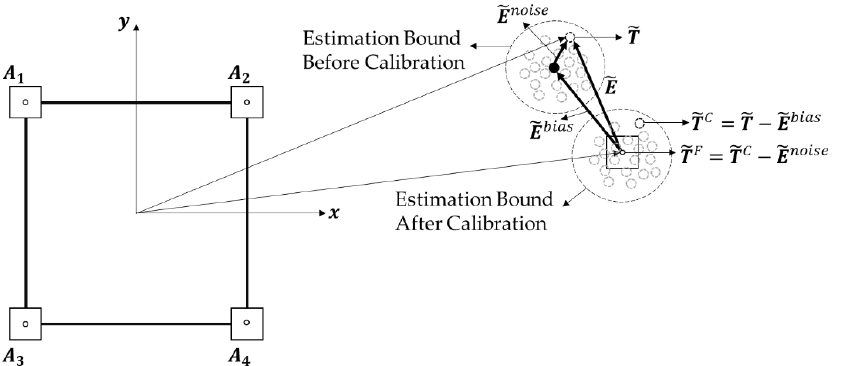
Figure 2. Component-wise classification of the estimation error. 𝑻̃ denotes the initial estimation using the LS approximation of the tag position. 𝑻̃ 𝐶 denotes the calibrated estimation by removing the bias F error (cid:101) E through initial calibration, and (cid:101) T denotes the final estimation, which removes (cid:101) E